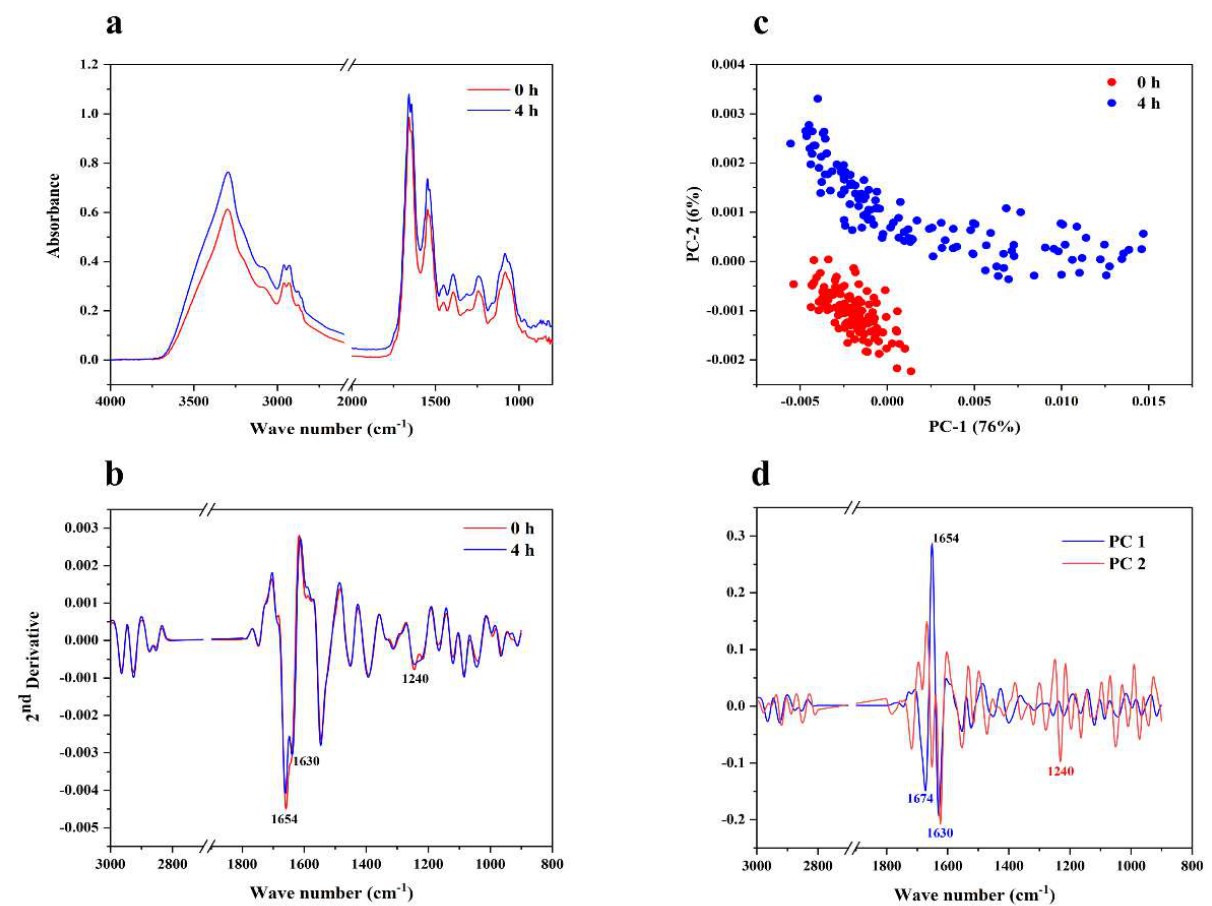
Figure 4. SR − FTIR analysis of B. cereus treated with VSDH at 4 h. ( a ) Representative average IR absorbance; ( b ) Second derivatives of FTIR spectra; ( c ) PCA scores plot; ( d ) their corresponding loadings plots .